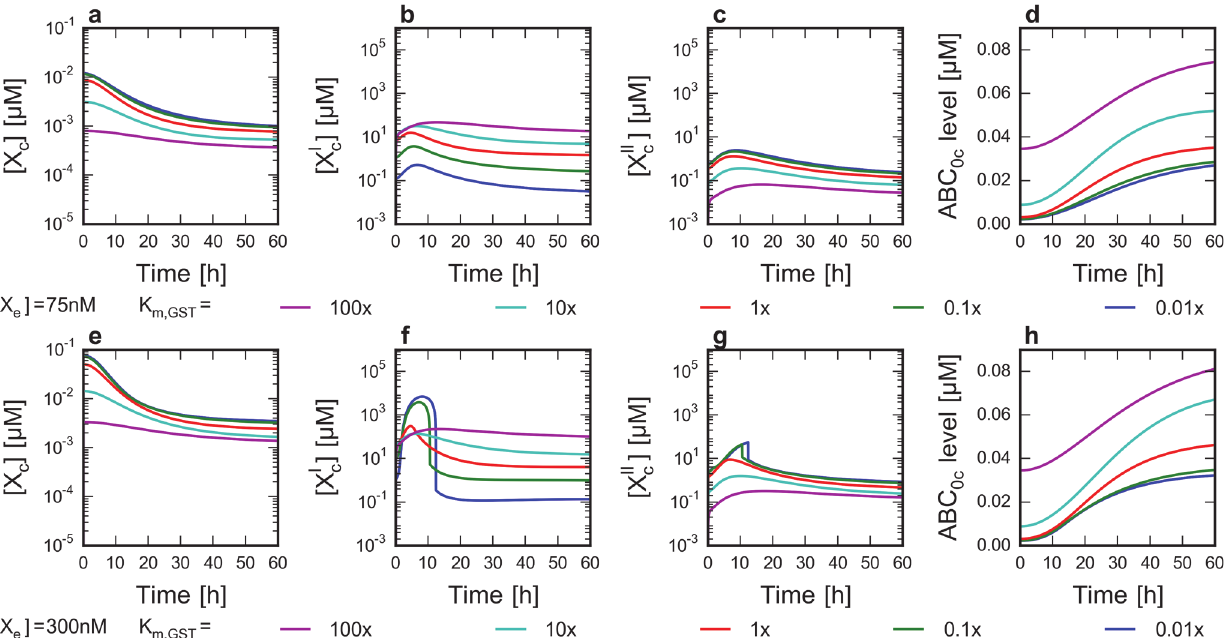
Fig 4. Effect of external drug concentration and GST affinity on the level of network components. Time course simulations were run from steady states belonging to different parameter sets as described in Methods. The Michaelis constants describing the affinity of GST to its substrates (X ’ c and X ’ bc ) were set to five different values encompassing four orders of magnitude. Parameter values are expressed as multiples of their default value (S3 Table). Concentration profile of X c , X ’ c , X ” c and the level of ABC 0 were plotted. a-d The effect of GST affinity to its substrates (K m values) at lower extracellular xenobiotic concentrations. [X e ] was set to 75 nM at t 0 = 0 h. e-h The effect of GST affinity to its substrates at higher extracellular xenobiotic concentrations. [X e ] was set to 300 nM at t 0 = 0 h.